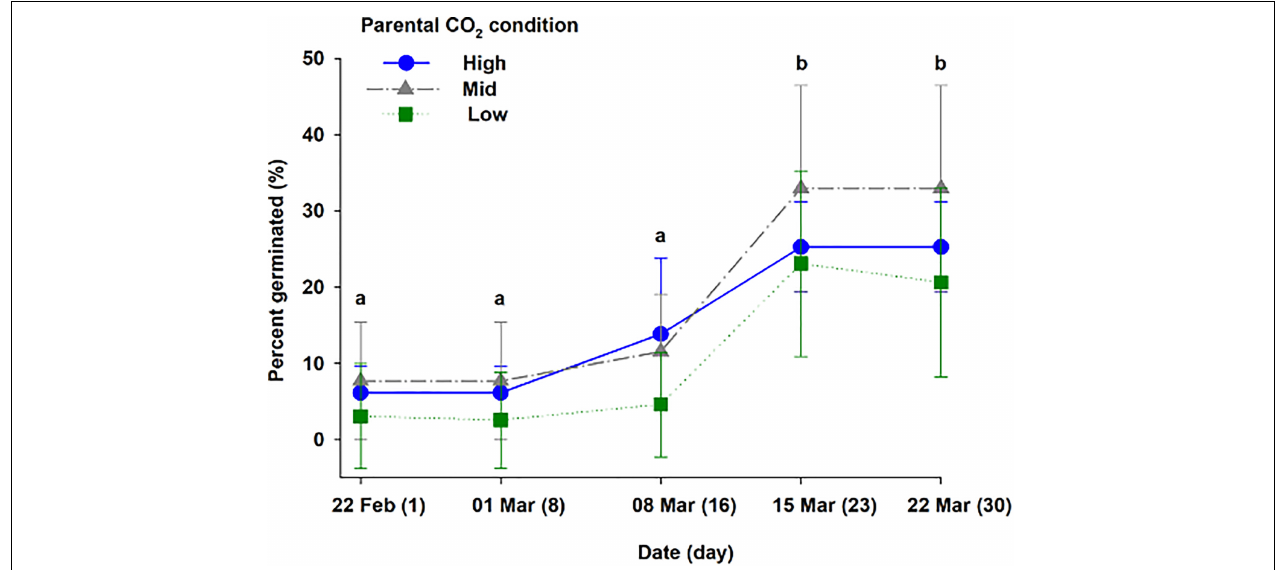
FIGURE 6 | Percent germinated out of viable seeds harvested from flowering shoots kept at three CO 2 conditions (high, mid, and low), corresponding to a pH T of 6.96, 7.54, 8.13 (Experiment 3, Supplementary Table 3 ). The different letters above bars represents statistical differences between days of study as specified by the results of a Holm–Sidak pairwise comparison test following a repeated measure two-way ANOVA. The ANOVA model indicated a main effect for time ( p < 0.001) but, not for treatment level nor for an interaction of time × treatment.